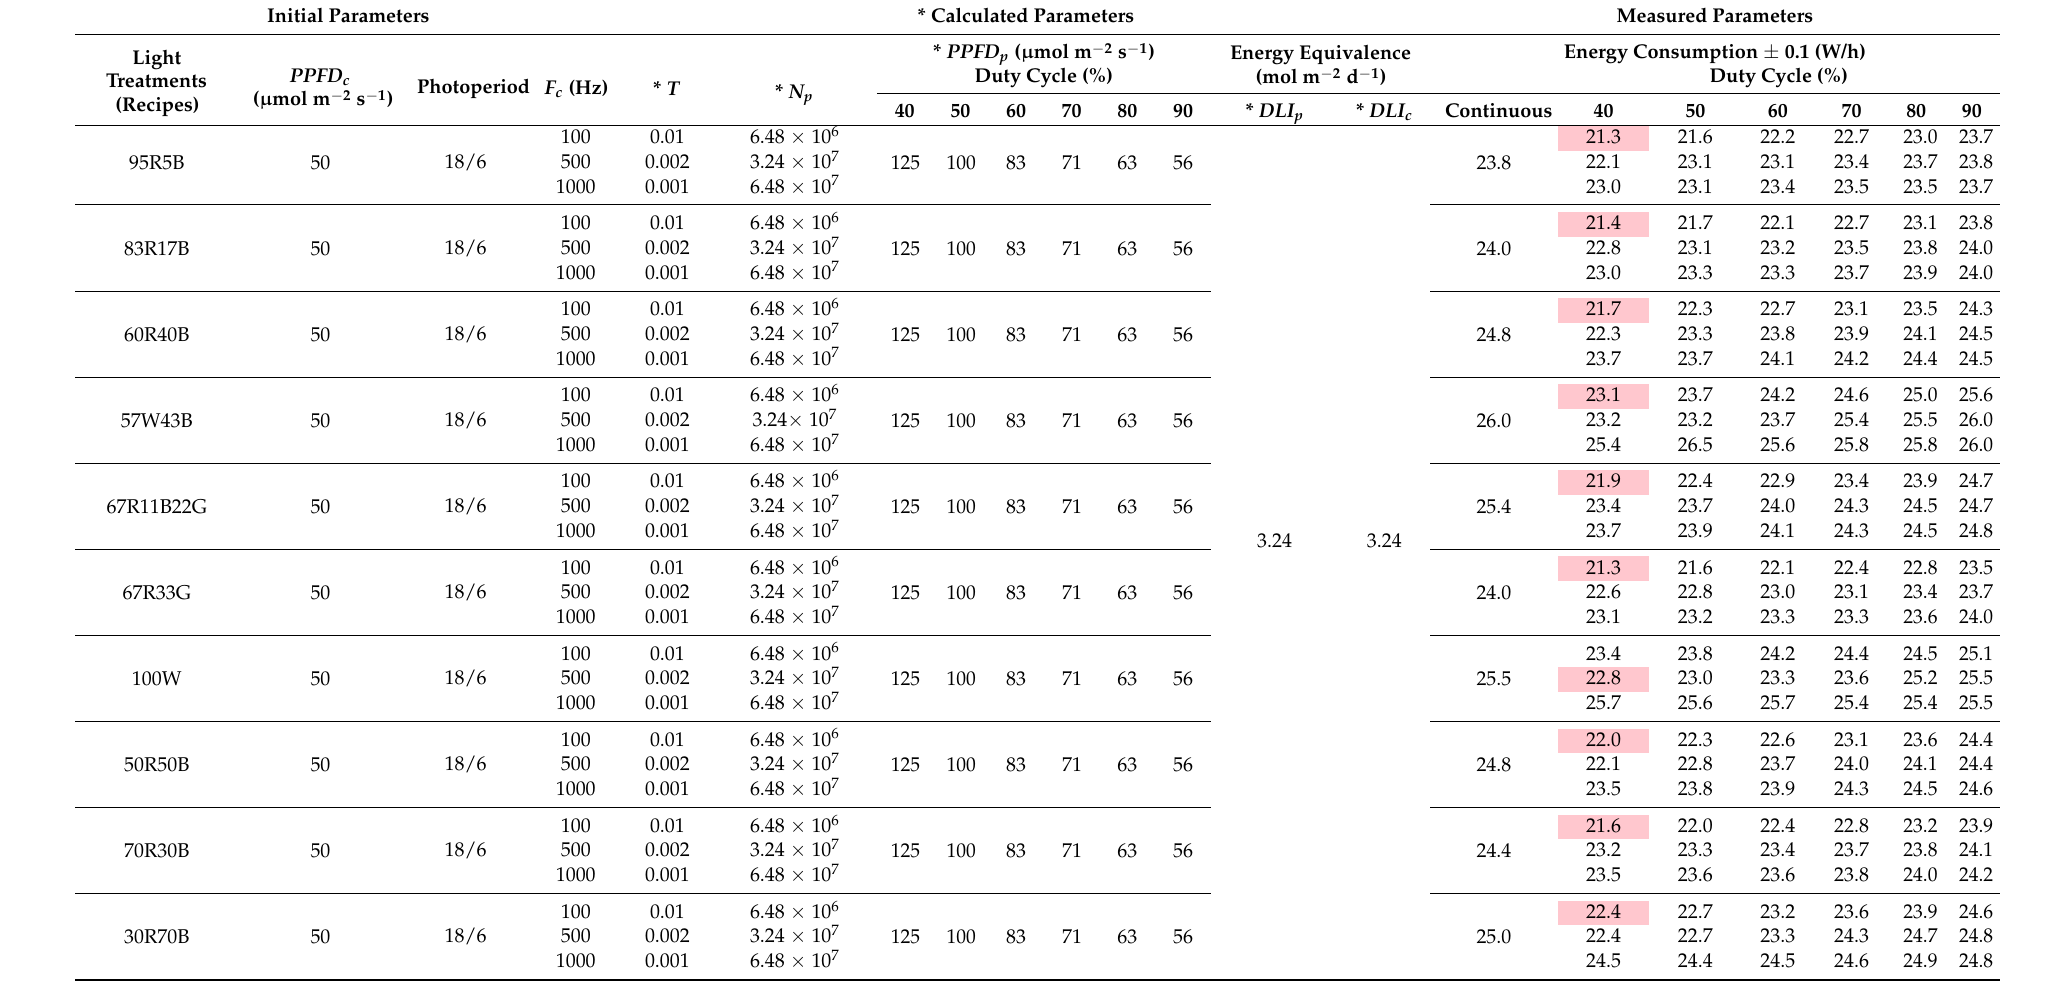
Table 4. Energy consumption of two lamps in the pulsed and continuous modes. The best energy savings values are shaded. Initial Parameters * Calculated